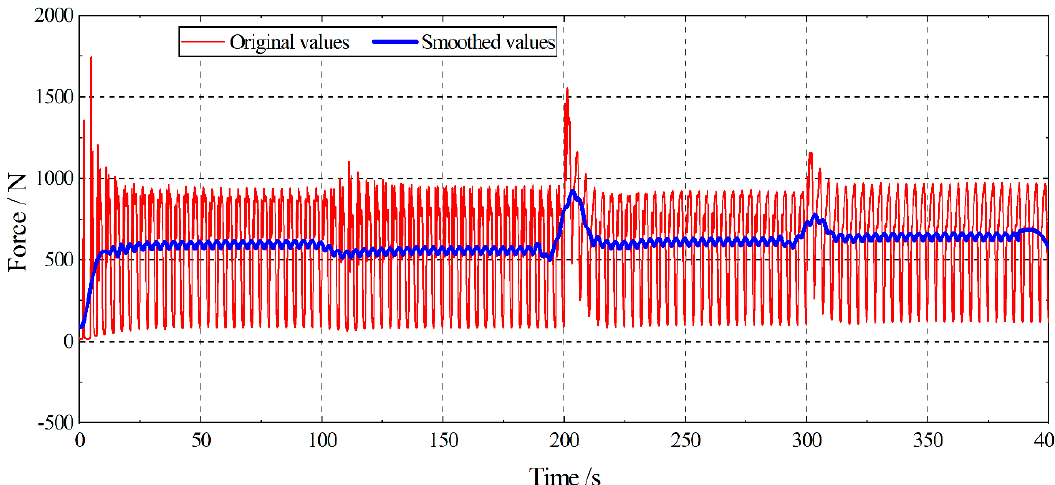
Figure 19. Time history of tension at the towing point.